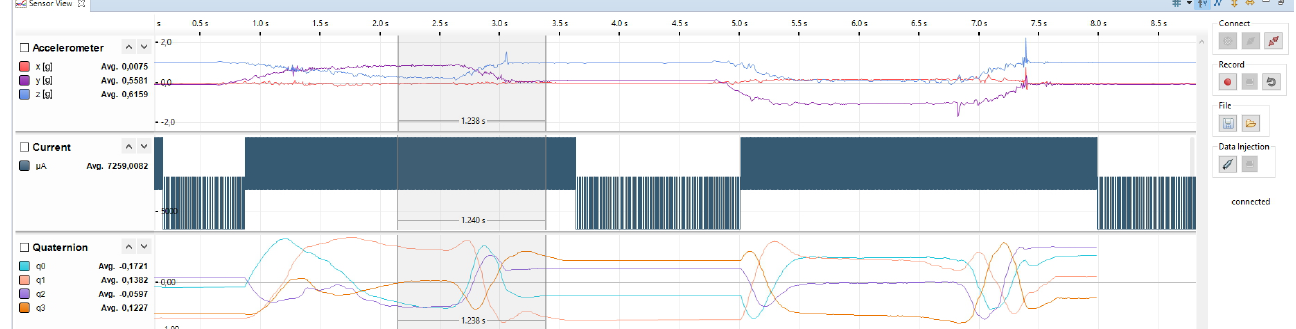
Figure 4. Sensor view in Eclipse